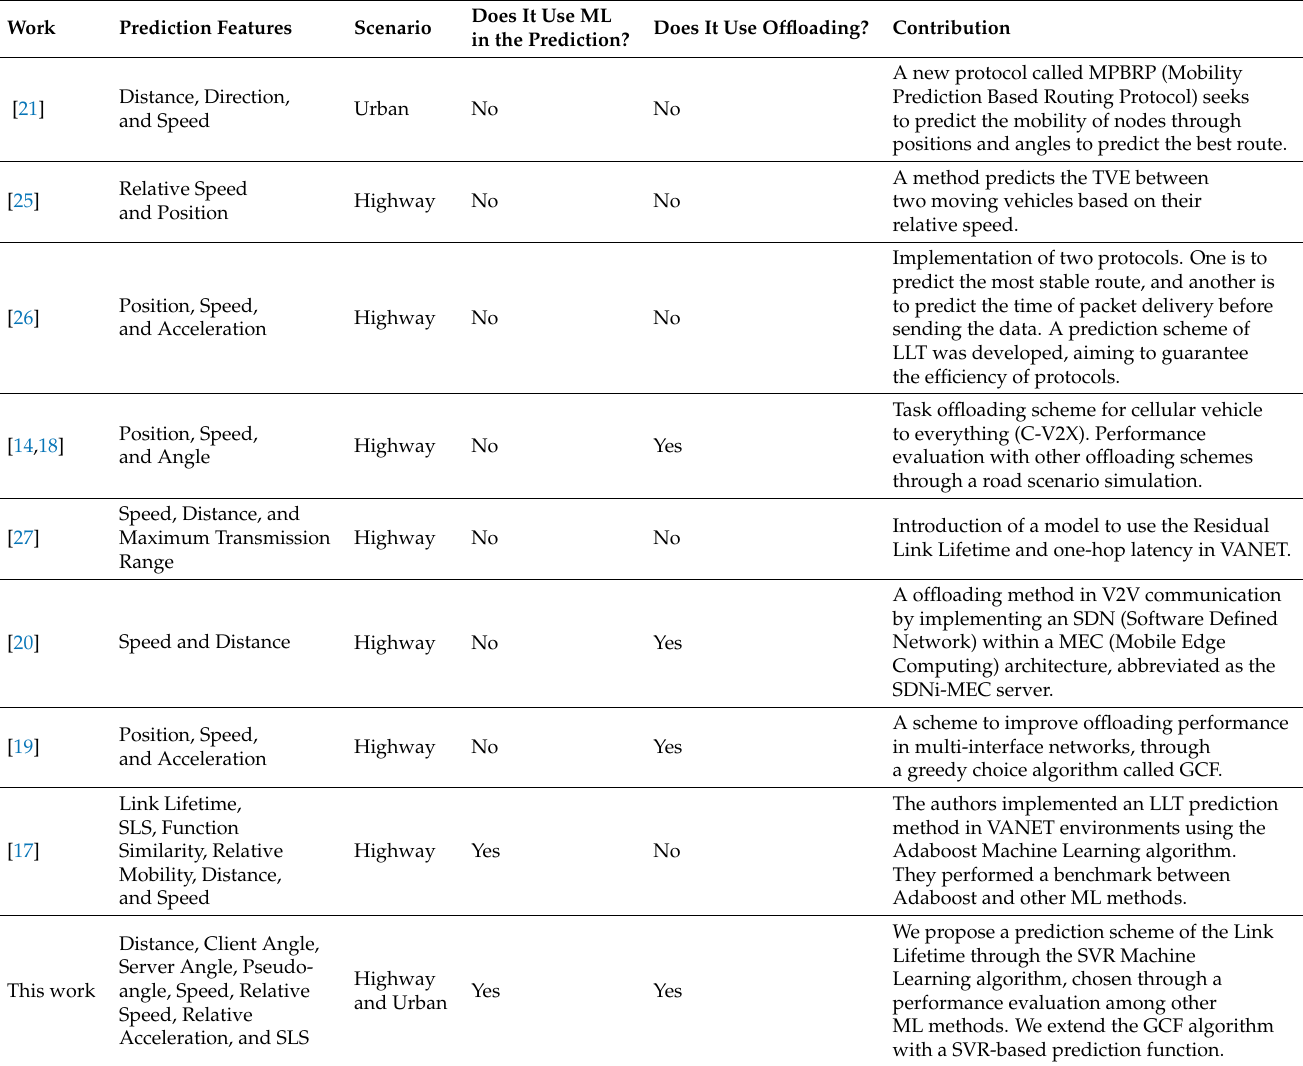
Table 1. Comparison with related